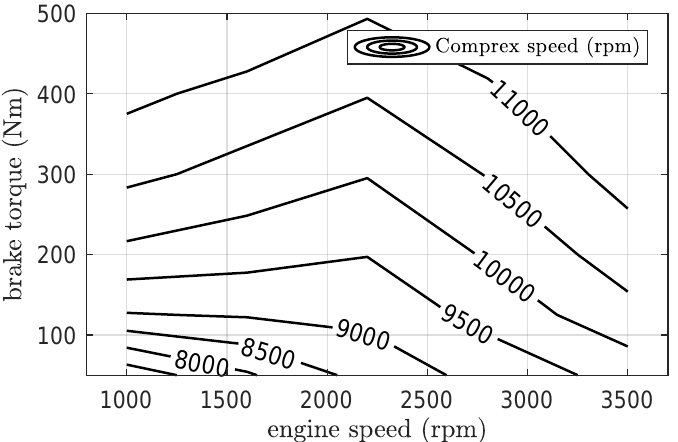
Figure 6. The steady-state rotor speed that was used for the experimental analysis.